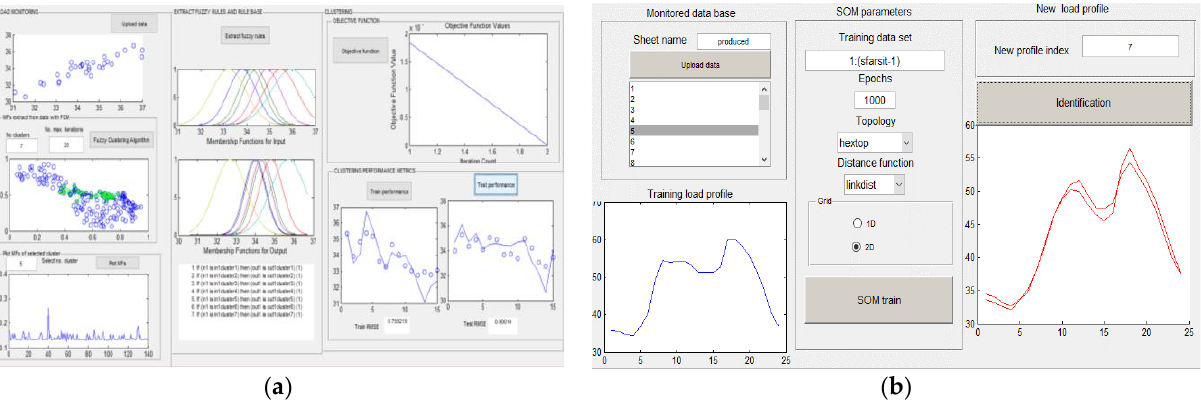
Figure 6. Neuro-fuzzy knowledge-based system graphical interface: ( a ) FCM panel ( b ) SOM panel.